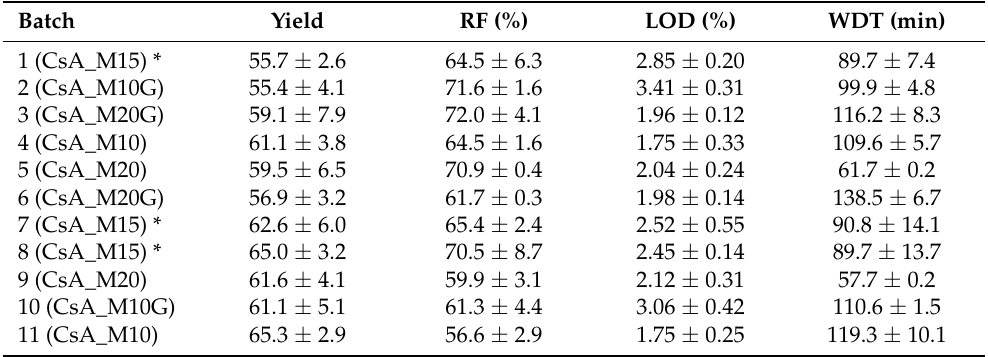
Table 2. Values of the CQAs investigated for the eleven CsA spray-dried powders: yield of the production process, respirable fraction (RF) < 5 µ m, loss on drying (LOD), and time parameter of Weibull equation (time for 63.2% of CsA dissolved from composite powders) indicated as WDT. Data presented as n = 3, mean value ±